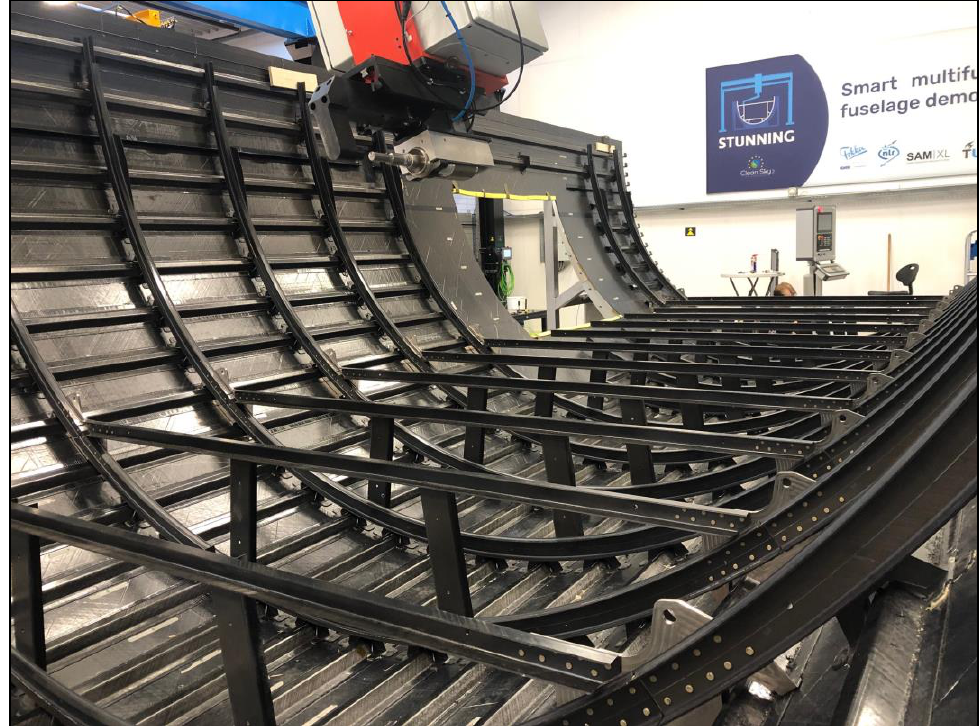
Figure 1. STUNNING demonstrator fuselage, made from welded thermoplastic composites [2]. Pro- ject funding source Clean Aviation Joint Undertaking. Photo Credit: SAM|XL. Reprinted with